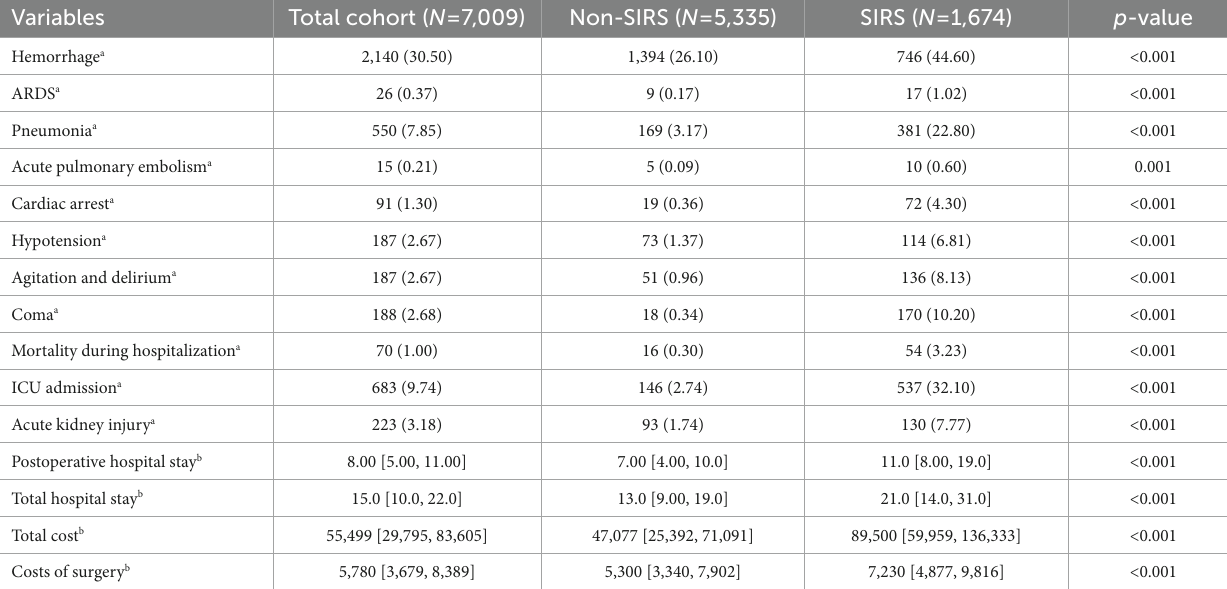
TABLE 2 Patients’ postoperative prognosis of non-SIRS and SIRS